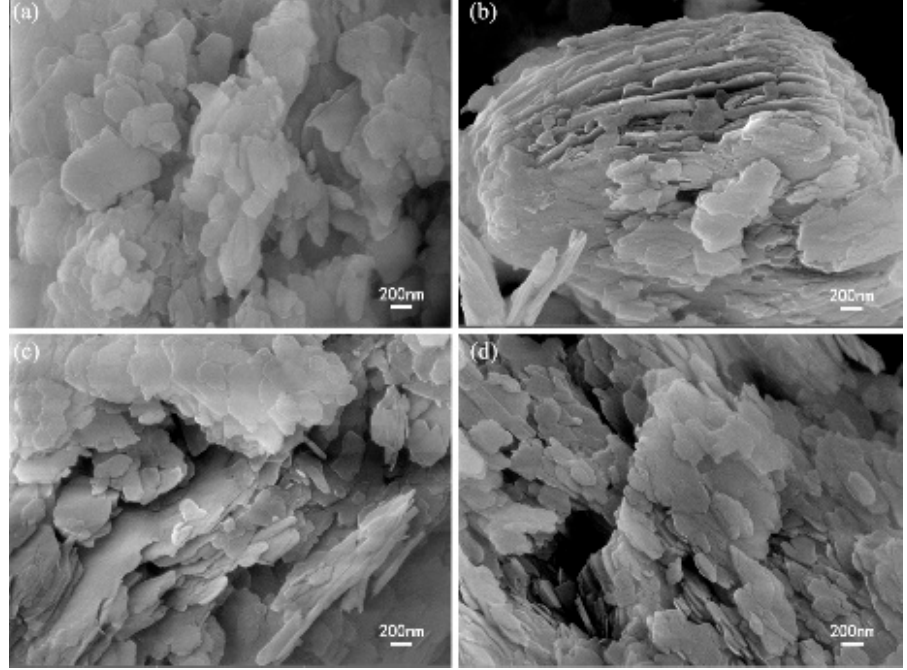
Figure 3. SEM images of the studied kaolin ( a ) Raw-Ka, ( b ) Ka-10 min, ( c ) Ka-30 min, ( d ) Ka-120